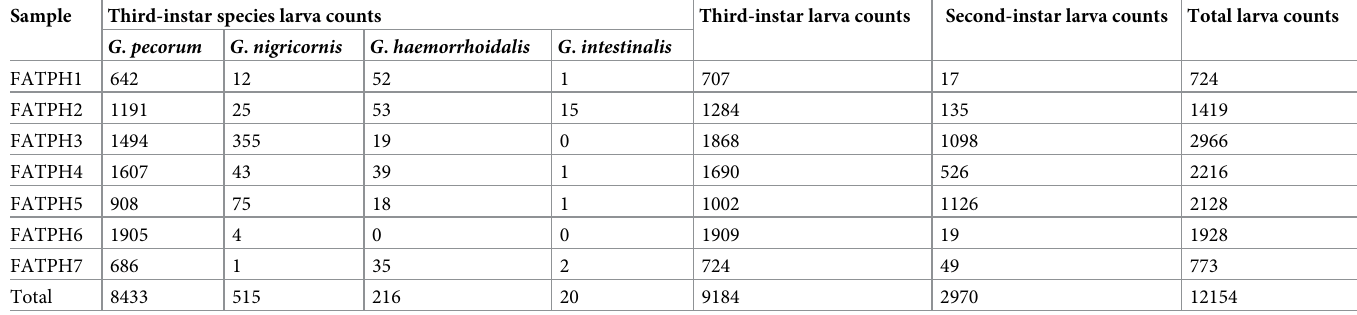
Table 1. Cumulative totals of the third instar and second instar larvae of horse botfly in feces of FATPHs collected in the 3 days following ivermectin administration.